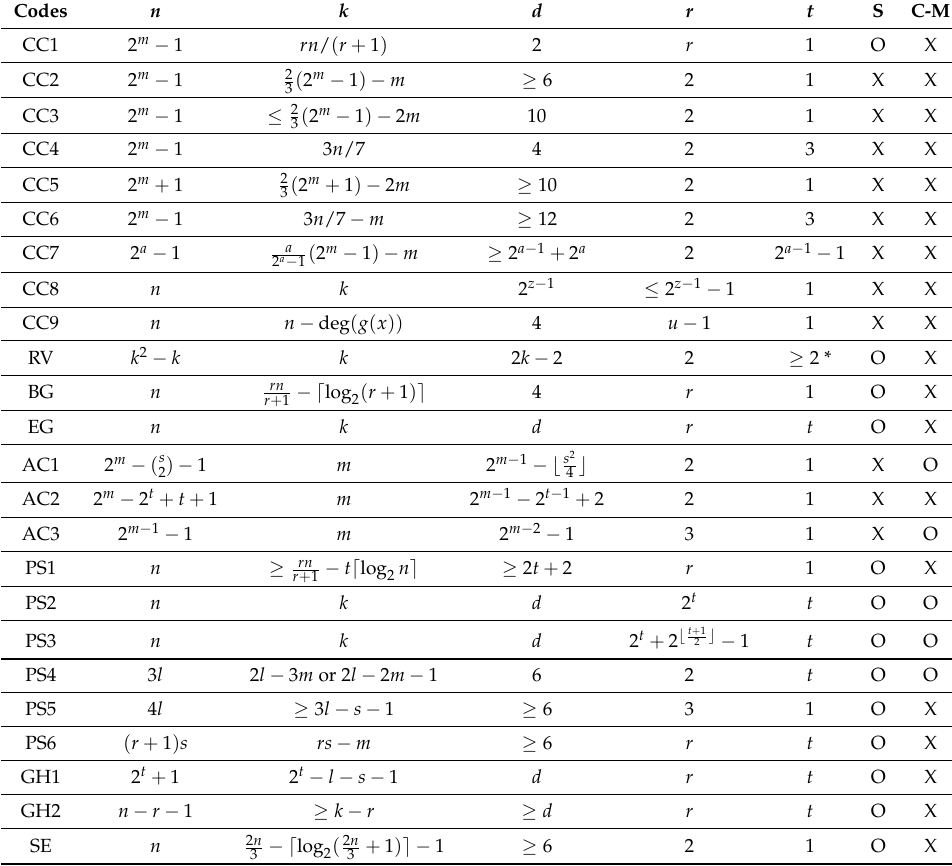
Table 1. Summary of parameters of various BLRC